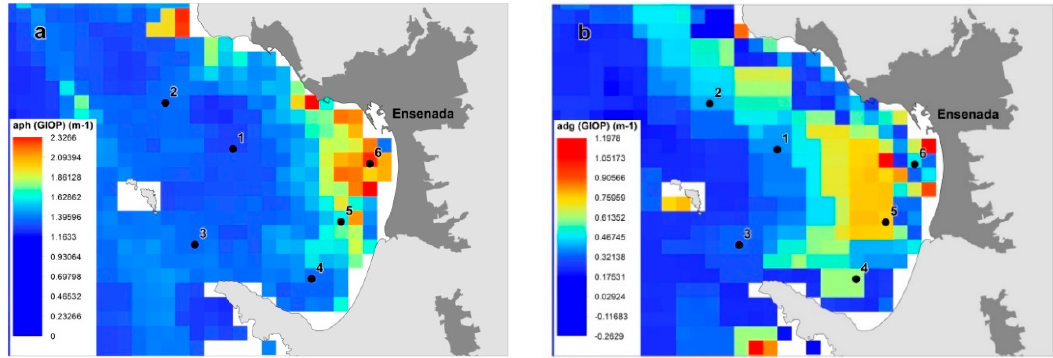
Figure 4. ( a ) a phy satellite and ( b ) a dCDOM satellite from 25 May to 10 June 2017 in Todos Santos Bay. Figure 4. ( a ) 𝑎 (cid:3043)(cid:3035)(cid:3052) (cid:3046)(cid:3028)(cid:3047)(cid:3032)(cid:3039)(cid:3039)(cid:3036)(cid:3047)(cid:3032) and ( b ) 𝑎 Figure 4. ( a ) 𝑎 (cid:3043)(cid:3035)(cid:3052) (cid:3046)(cid:3028)(cid:3047)(cid:3032)(cid:3039)(cid:3039)(cid:3036)(cid:3047)(cid:3032) and ( b ) 𝑎 𝑑𝐶𝐷𝑂𝑀 𝑠𝑎𝑡𝑒𝑙𝑙𝑖𝑡𝑒 from 25 May to 10 June 2017 in Todos Santos Bay. 𝑑𝐶𝐷𝑂𝑀 𝑠𝑎𝑡𝑒𝑙𝑙𝑖𝑡𝑒 from 25 May to 10 June 2017 in Todos Santos Bay.